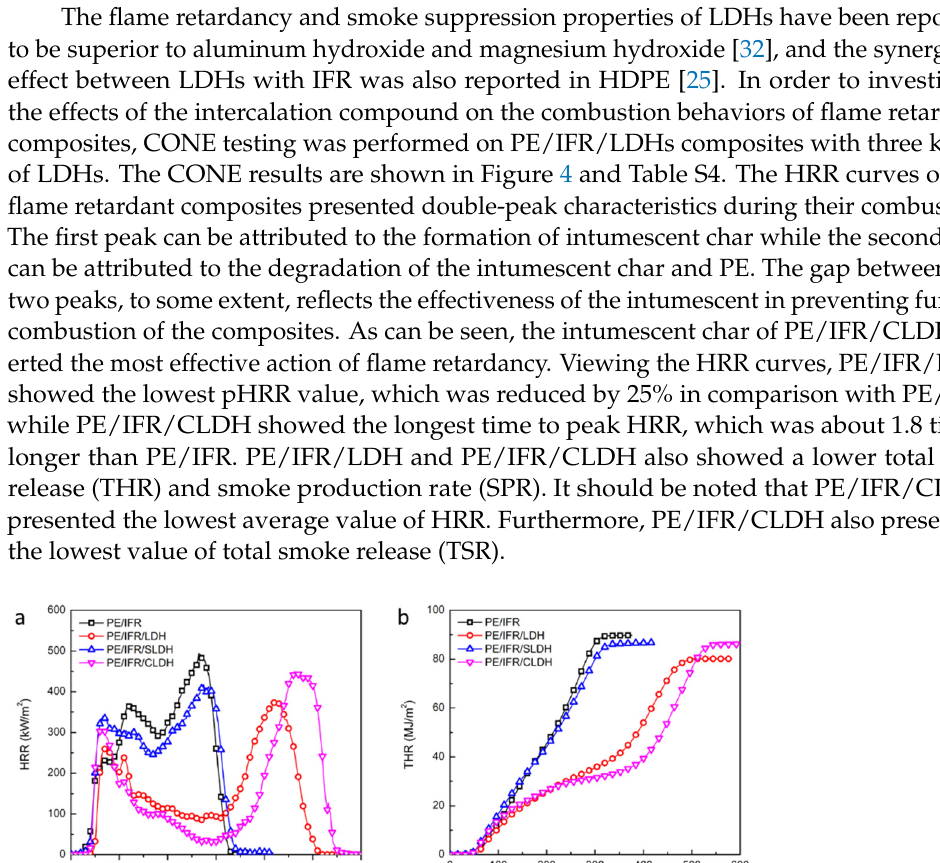
Figure 5. Temperature versus time curves of the flame retardant composites during CONE testing. 3.4. Char Structure after CONE Testing The intumescent char functions as a barrier to heat and mass transfer during the com- bustion, the structure of which is of great importance in the flame retardancy of the com- posites. The morphological structure of the char after CONE testing was photographed by a digital camera in Figure S3 and observed by SEM in Figure 6, respectively. The char of PE/IFR showed the rough surface of a stacked structure with cracks and holes. In